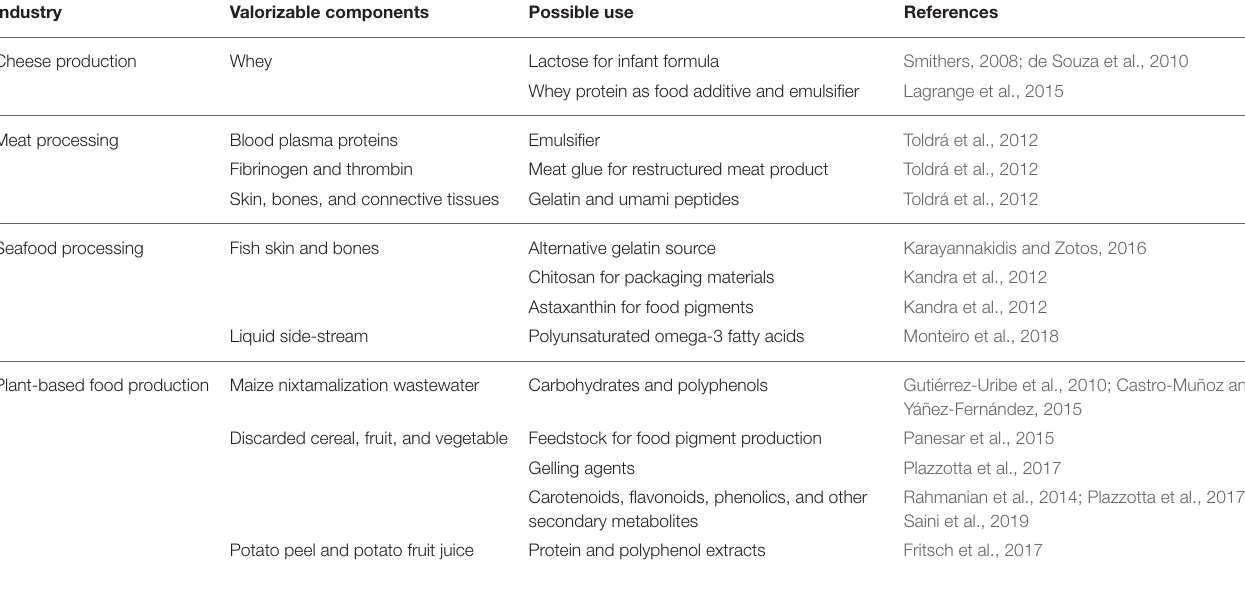
TABLE 2 | Summary of potentially functional and nutritional food components from cheese production, meat processing, seafood processing, and plant-based food production by-products.